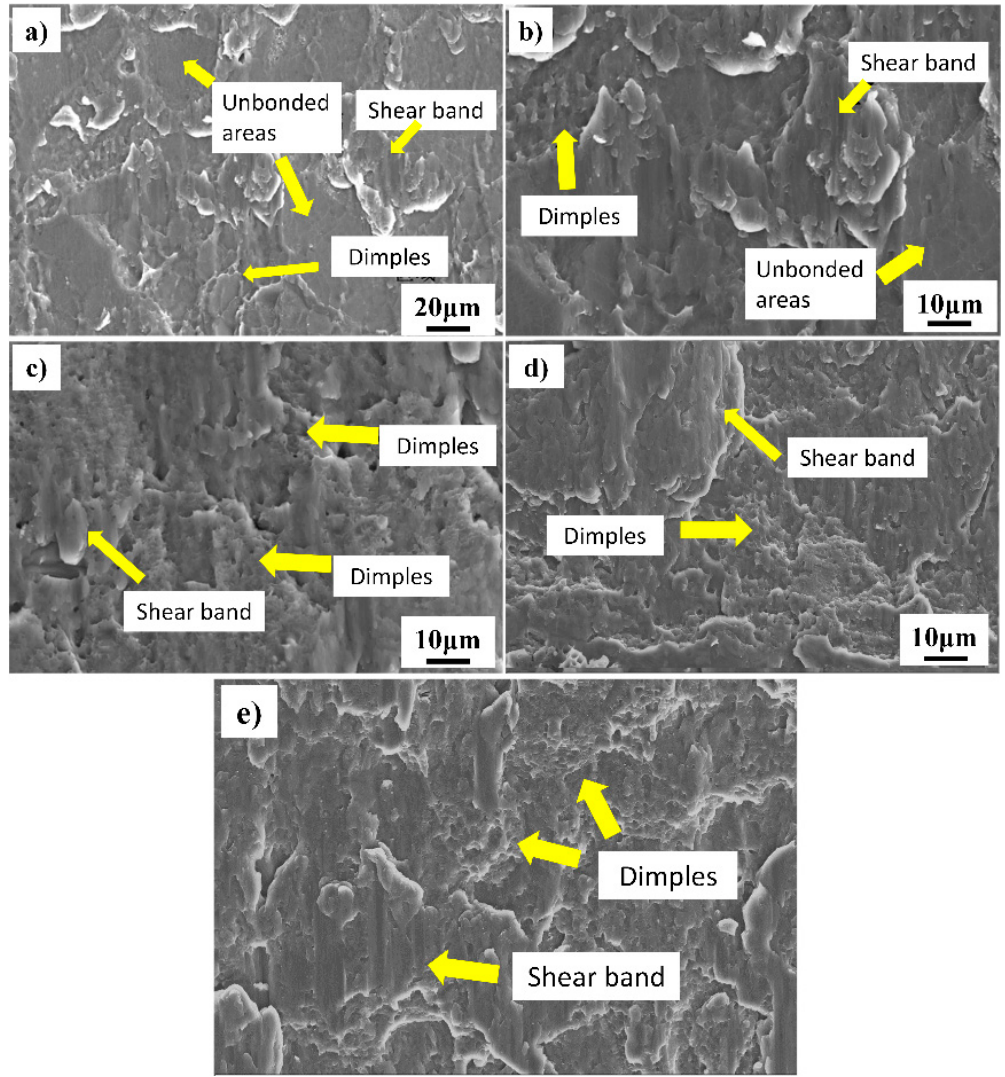
Figure 8. Shear fracture morphology of the joints bonded under different temperatures (6 MPa–60 min): ( a ) 430 °C; ( b ) 460 °C; ( c ) 490 °C; ( d ) 520 °C; ( e ) 550 °C.